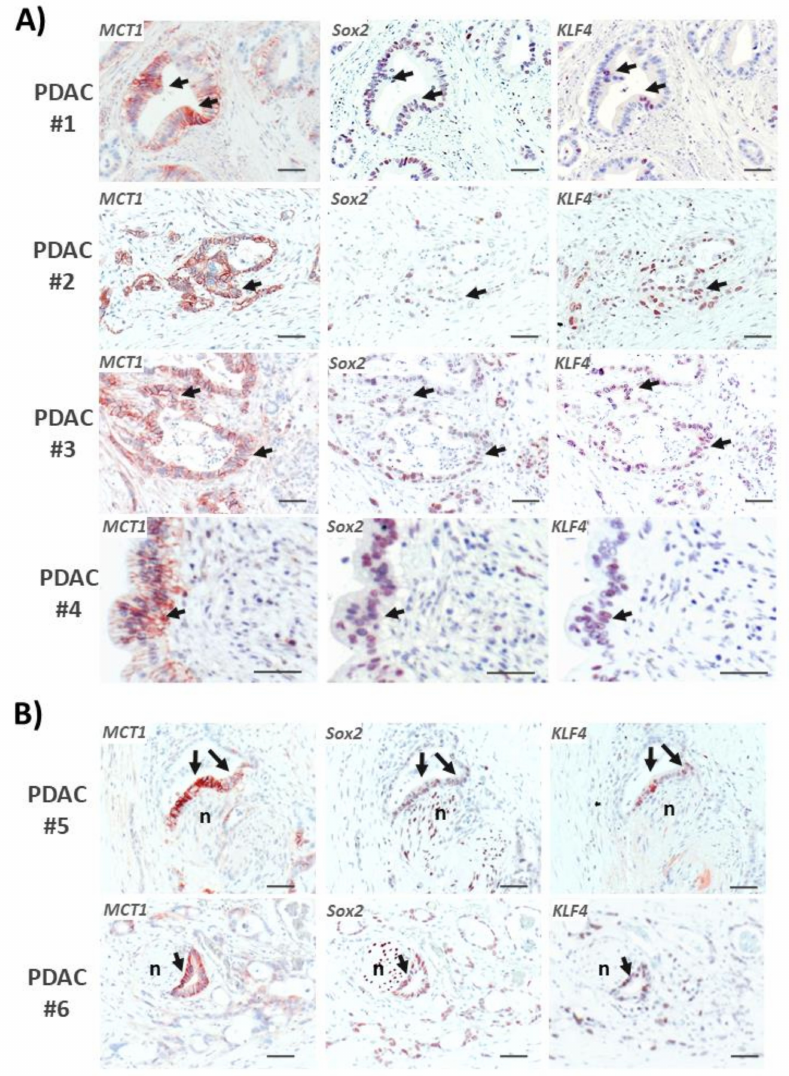
Figure 7. MCT1 expressing PDAC tissue areas colocalized with KLF4, partially reciprocally to Sox2. Consecutive sections of FFPE tumor tissues from PDAC patients were stained with antibodies directed against MCT1, KLF4, and Sox2, receptively. Images from ( A ) four PDAC tissues and ( B ) from two perineural invasive PDACs (PNI) are shown. Arrows indicate MCT1 positive cells exhibiting colocalization with strong KLF4 and weak Sox2 expression; n: neural cells. (scale bar = 50 µ